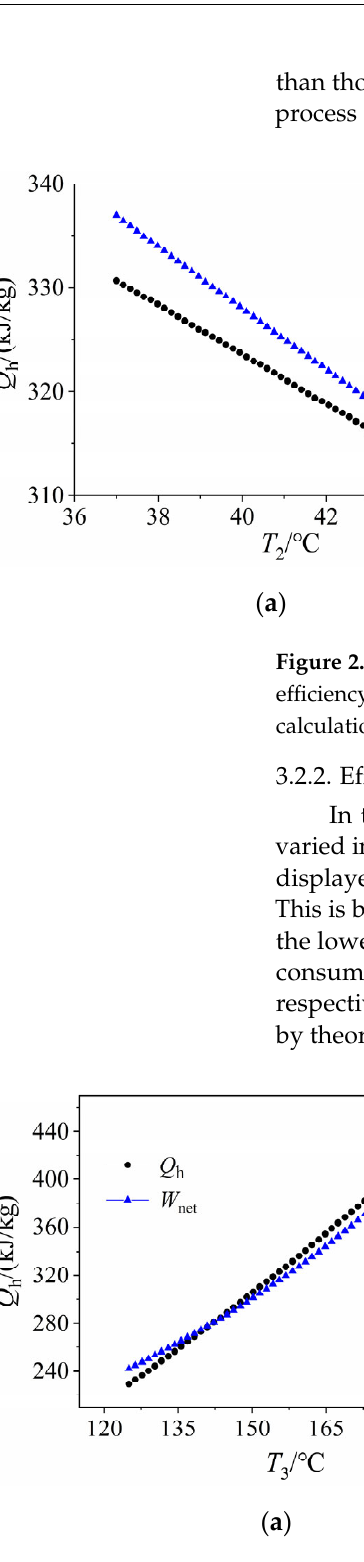
Figure 3. The variation of thermodynamic performance with T 3 : ( a ) Q h and W net ; ( b ) the thermal efficiency and exergy efficiency by numerical simulations ( η th,ns and η ex,ns ) and those by theoretical calculations ( η th,tc and η ex,tc ).